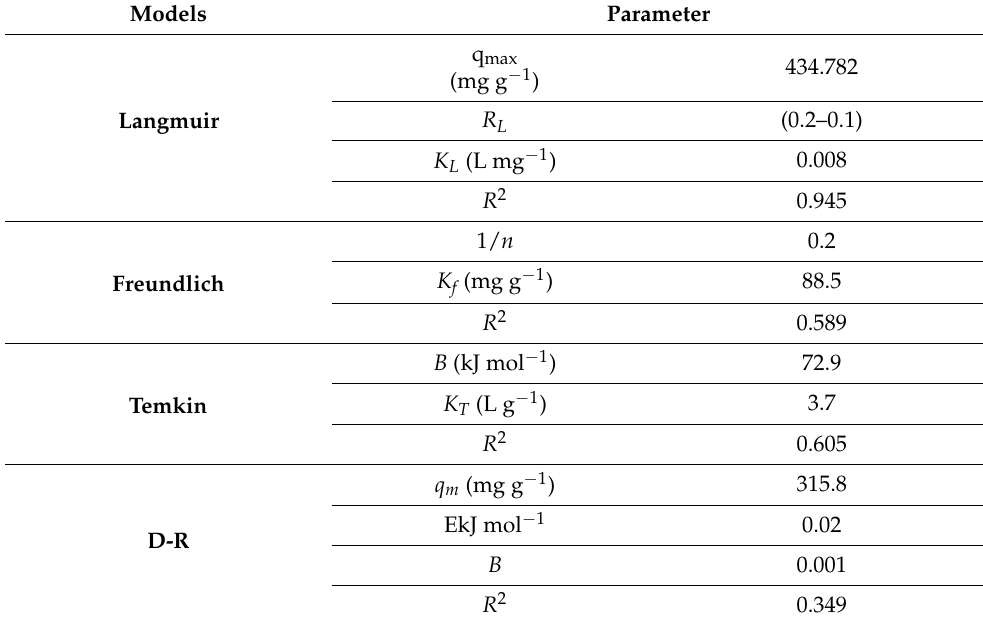
Table 3. Adsorption isotherm parameters for removal of MB dye by O -CM-chitosan hydrogel.